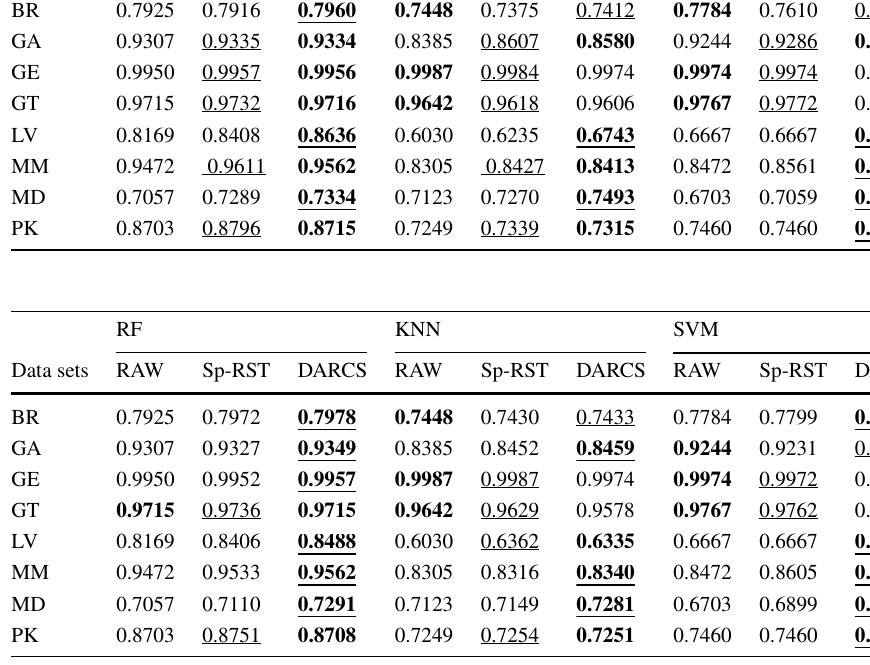
partition classification accuracy comparison